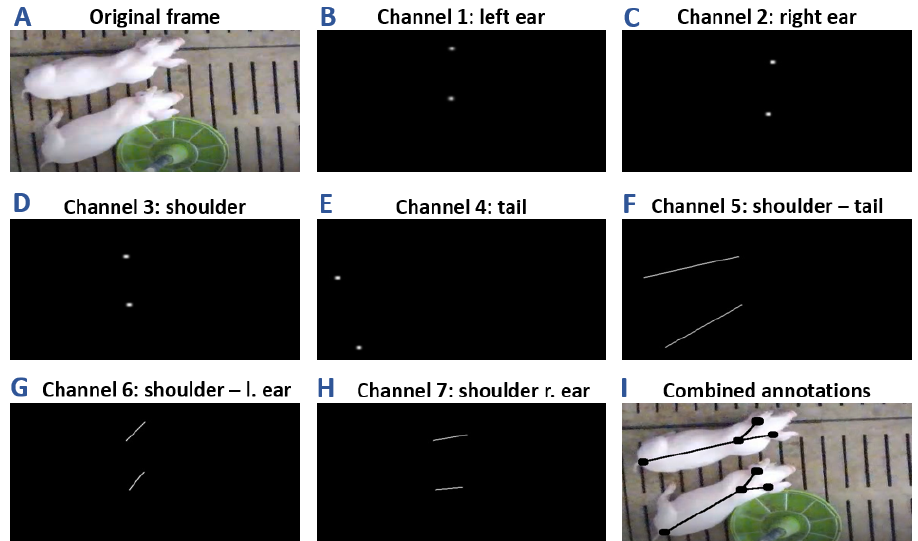
Figure 3. ( A ) The original image which serves as the input for the CNN. ( B – H ) The corresponding ground truth annotations containing the positional body part information which are used for the training process. ( I ) The original image combined with the ground truth annotations.